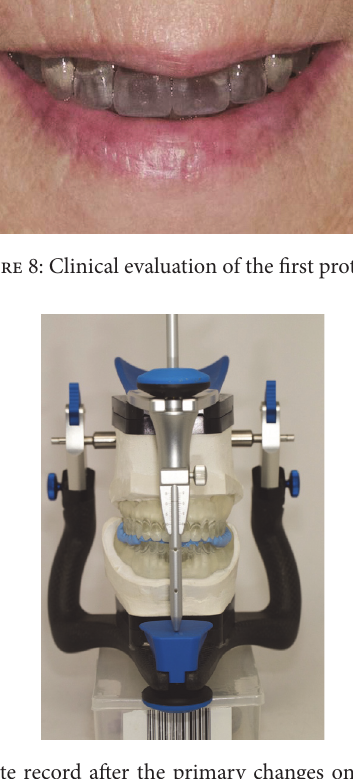
Figure 9: Bite record after the primary changes on the occlusion plane.